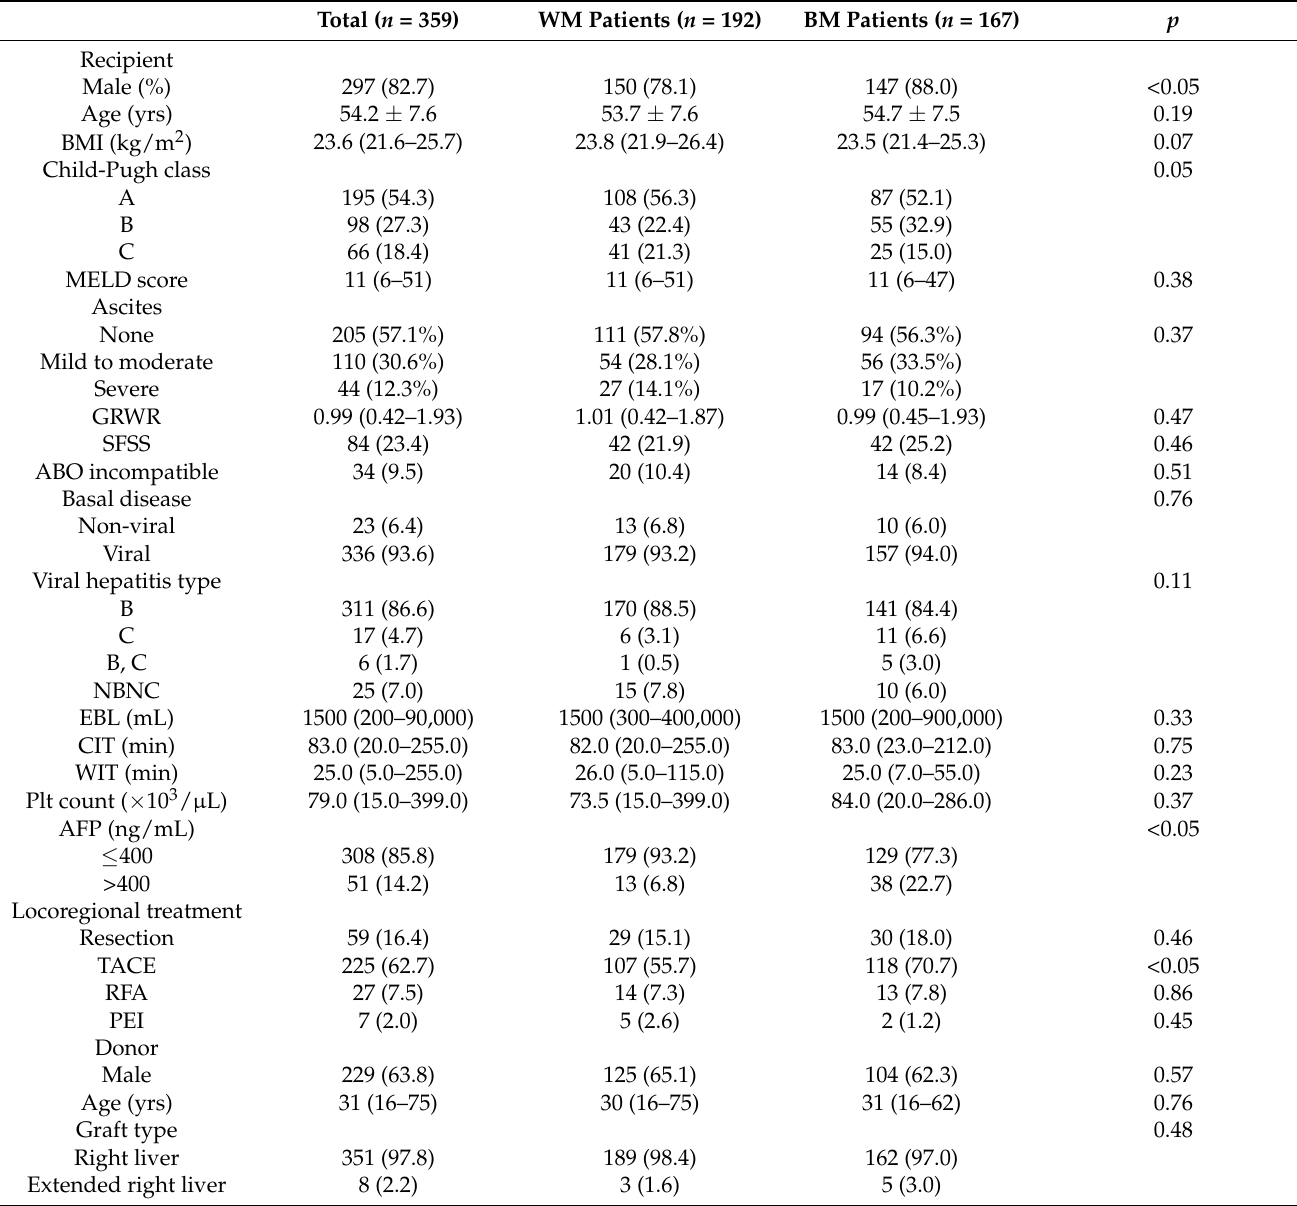
Table 1. Baseline characteristics of patients undergoing LDLT for HCC and assessed according to the Milan criteria. Total ( n = 359) WM Patients ( n = 192) BM Patients ( n =